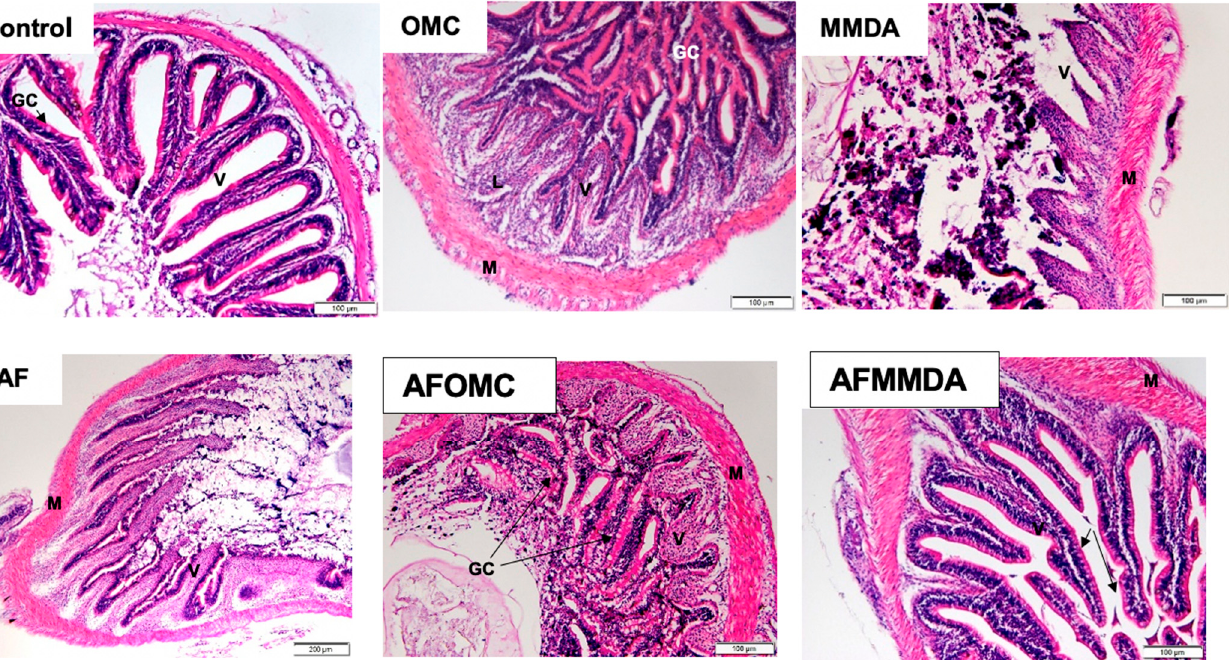
a 12:12 light: dark photoperiod cycle using fl uorescent tubes as a light source. The dis- solved oxygen concentration ranged from 6.18 to 6.40 mg/L, pH ranged from 7.68 to 7.74, and the ammonia-nitrogen concentration ranged from 0.51 to 0.81 mg/L. No signi fi cant ( p > 0.05) di ff erences were found in water quality parameters among the treatments. There- fore, all the water quality parameters were within acceptable ranges for fi sh. 4. Discussion Nile Tilapia fi ngerlings used in the experiment fed 0.5 mg of AFB1 per kg of feed did not manifest clinical signs of exposure. During the fi rst 10 weeks of the growth period in this study, the survival of tilapia ranged from 50–80% among the treatment replicates, which is normal in a recirculatory aquaculture system with a high-density culture. Fur- thermore, no signi fi cant di ff erences were found when comparing OMC, MMDA, and AF. This indicates that fi sh culture conditions and the health of fi sh remained asymptomatic when AFB1 was applied up to 0.5 mg per kg of feed for up to 12 weeks among the treat- ments (AF, AFOMC, and AFMMDA). Low growth performance with AFB1 has been reported in many species, such as Nile tilapia [30,35,44,45], grass carp [46], penaeid shrimps [9,11,47,48], rainbow trout [49–51], Gibel carp [52], and seabass [53]. During this trial period of 12 weeks, there were no ad- verse changes a tt ributed to AFB1 exposure. Similar results were found when doses of 19, 85, 245, 638, 793, and 1641 µg/kg were used. Within the fi rst 10 weeks, there was no sig- ni fi cant di ff erence in growth between the AFB1 groups. However, by the 15th week, they observed signi fi cant changes among the groups [30,54]. Thus, it can be concluded that the present research indicated that the dose of AFB1 (500 µg/kg diet) was rather low, and the